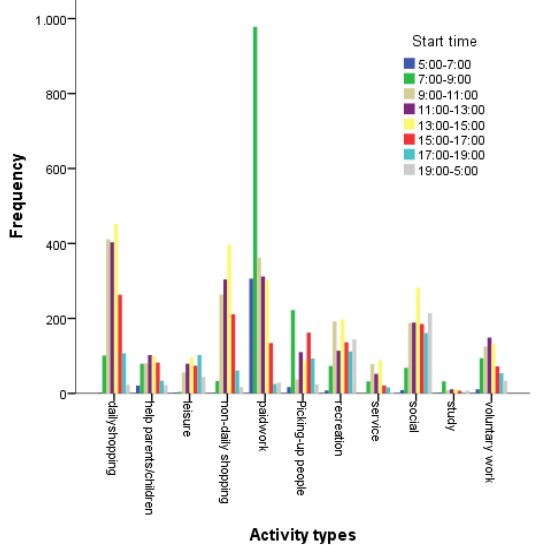
Figure 3. Start time of activities